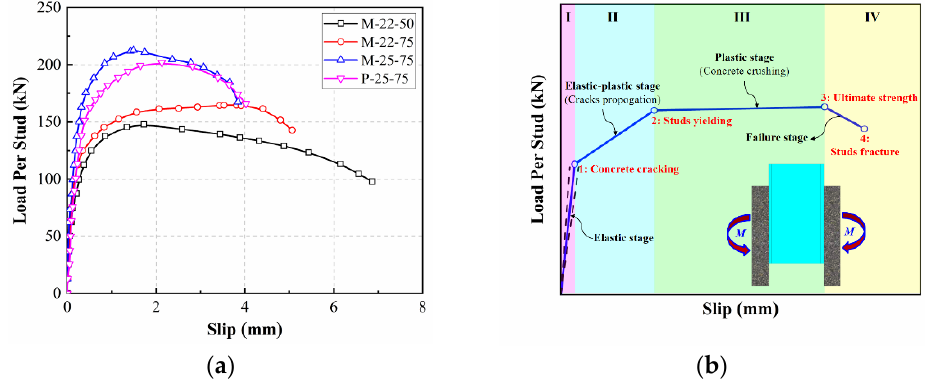
Figure 6. Load–slip relationships: ( a ) comparison of load–slip relationships; ( b ) general load–slip response.